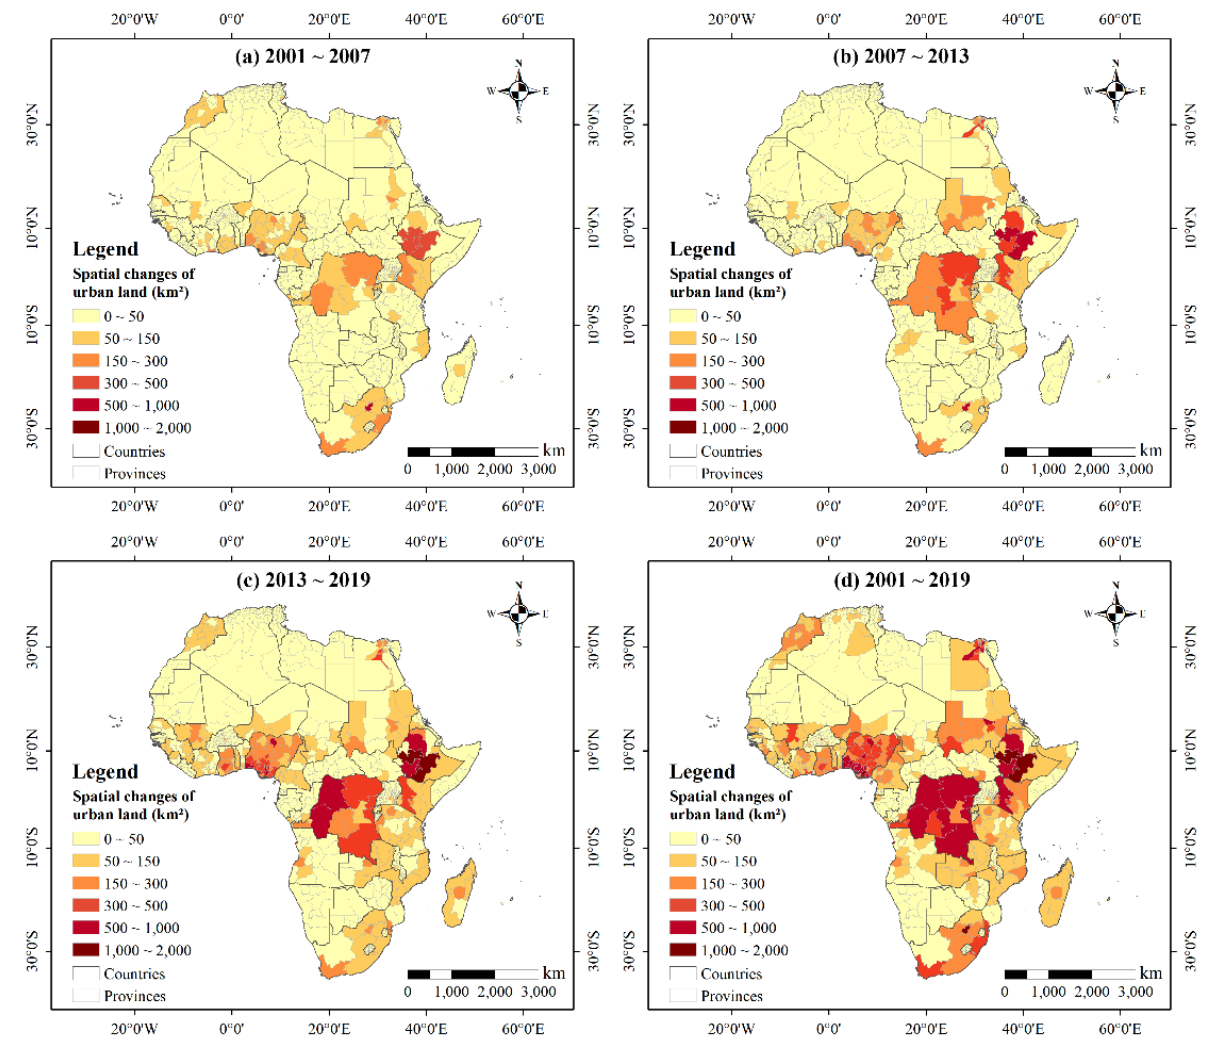
Figure 9. Spatial changes of urban land in different periods.